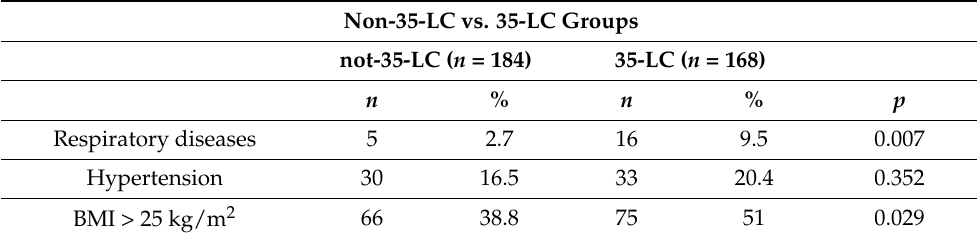
Table 3. Comparison of the frequencies of respiratory diseases, hypertension and BMI > 25 kg/m 2 between non-35-long COVID and 35-long COVID